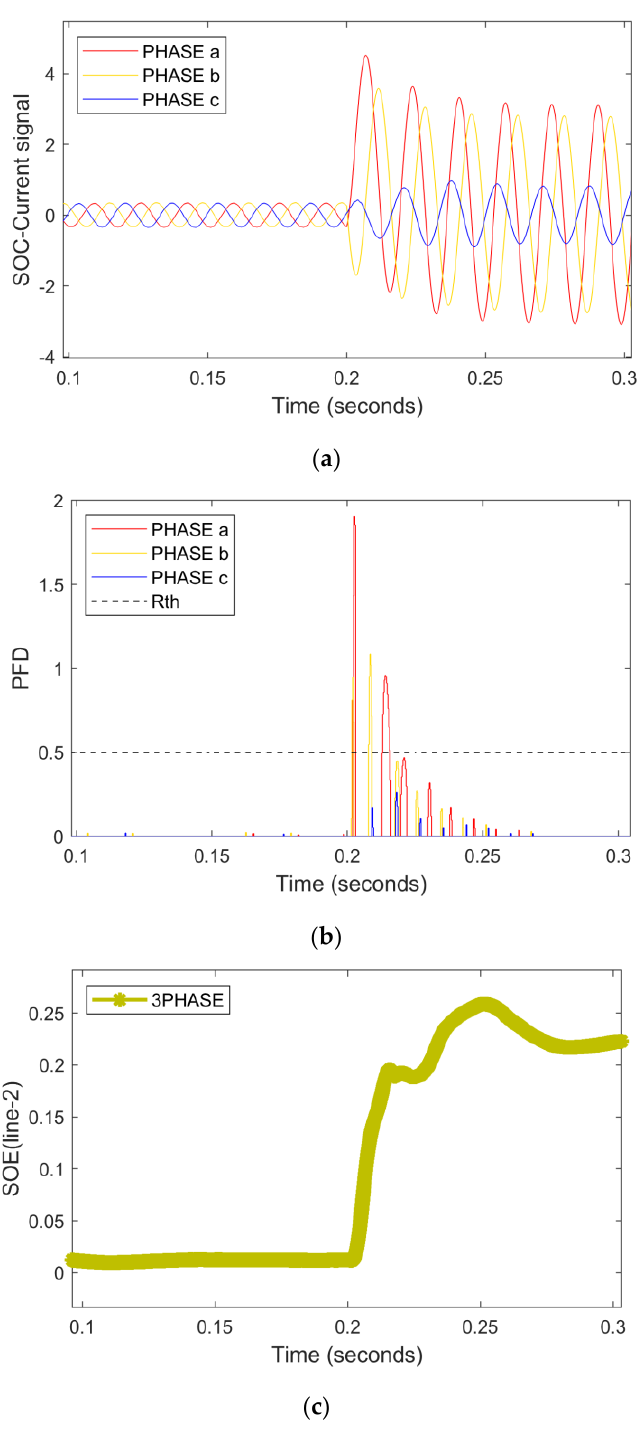
Figure 6. An LI double line-to-ground fault with Z L = 0.1 Ω hits phase A and B in TU mode. ( a ) Current signals ( b ) PFD ( c ) RNN-assisted SOE.